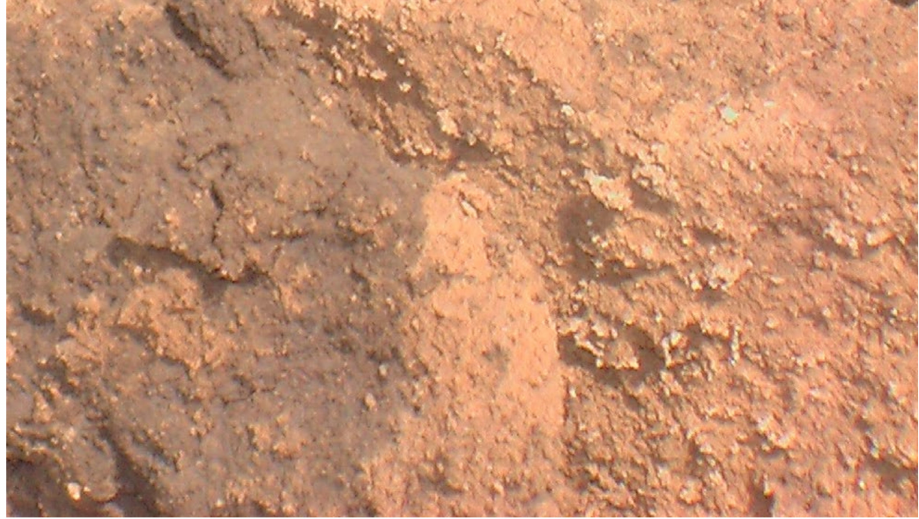
Figure 6. Solonetz profile wall at a depth about 20–35 cm (40 years after the PTN–40 plowing). After PMS–70 intra-soil processing, the soil layer 20–45 cm acquired a uniform dark- brown color and become morphologically homogenous. In consequence, the soil geophysi- cal and morphological properties become much more suitable for plant root